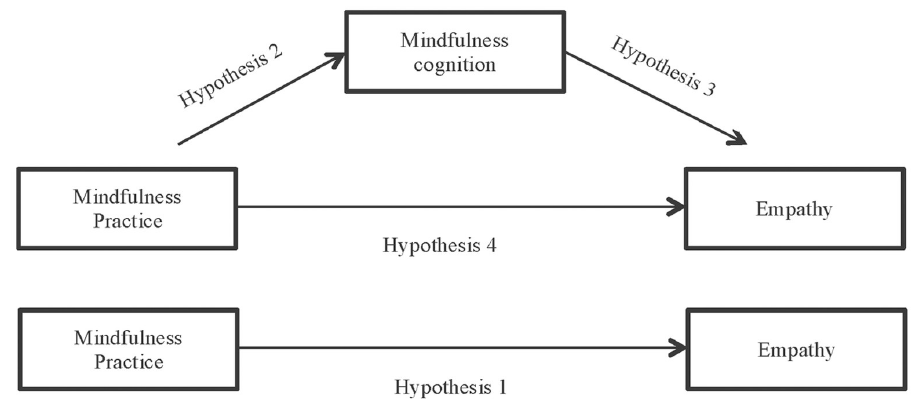
Fig 1. Hypothesized mediation model: Indirect effect of mindfulness practice on empathy through mindfulness cognition and total effect of independent variable on dependent variable.